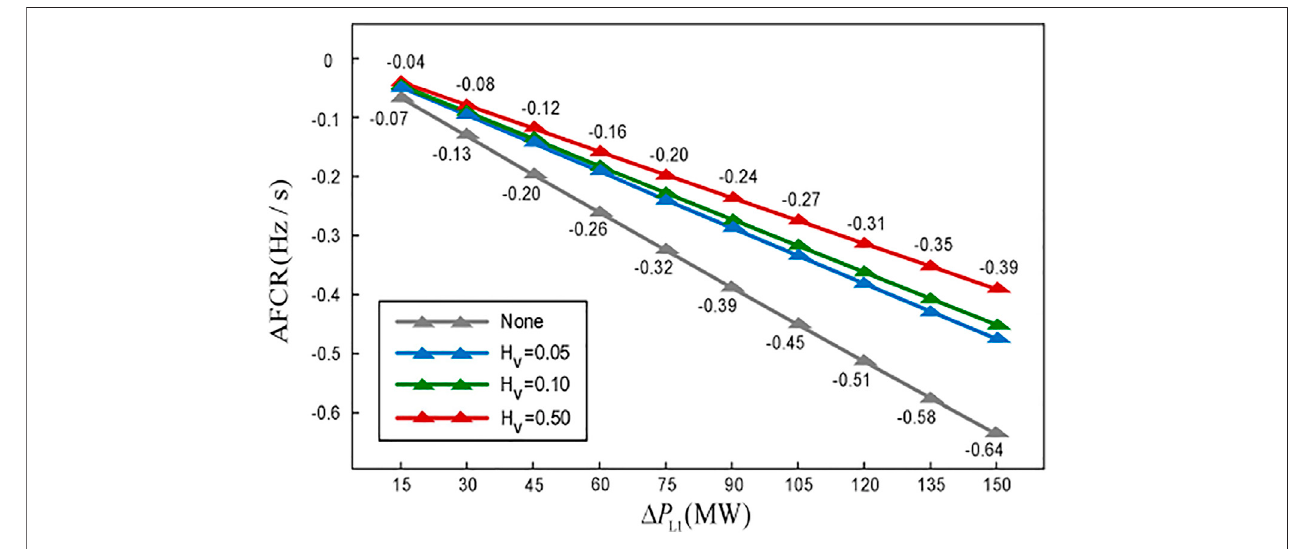
FIGURE 15 | Variation in the AFCR with respect to H v .